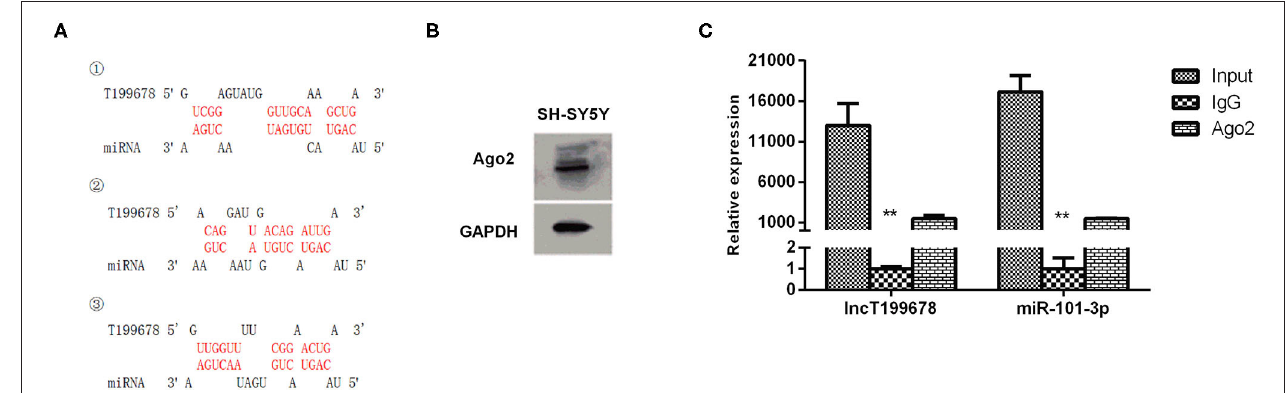
FIGURE 4 | Interaction between lncRNA-T199678 and miR-101-3p in SH-SY5Y cells. (A) The potential-binding sites between lncRNA-T199678 and miR-101-3p were shown. (B) The expression of Ago2 in SH-SY5Y cells by Western blot. (C) Ago2-RNA immunoprecipitation (RIP) followed by qPCR was conducted to determine